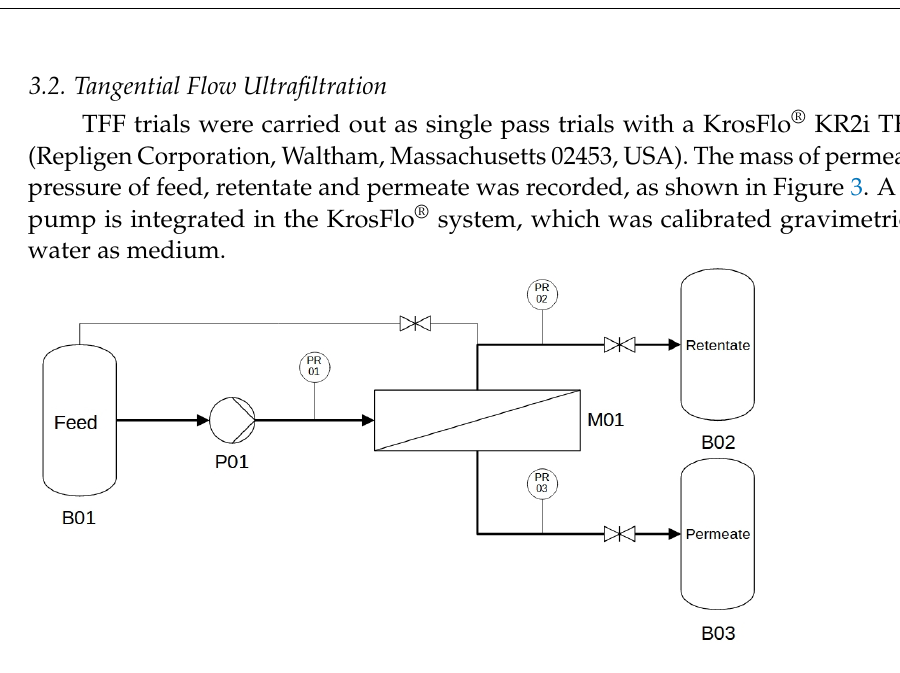
Figure 3. Process flow diagram of the experimental setup for UF experiments. B01 feed reservoir, B02 retentate reservoir, B03 permeate reservoir, P01 peristaltic pump, M01 hollow fiber module, PR pressure sensor.